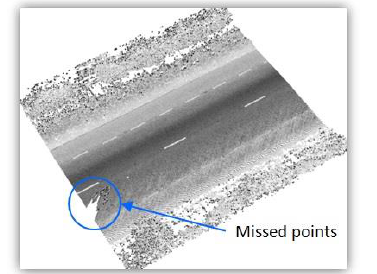
Figure 2: Missed points as circled in blue in the section of LiDAR data.